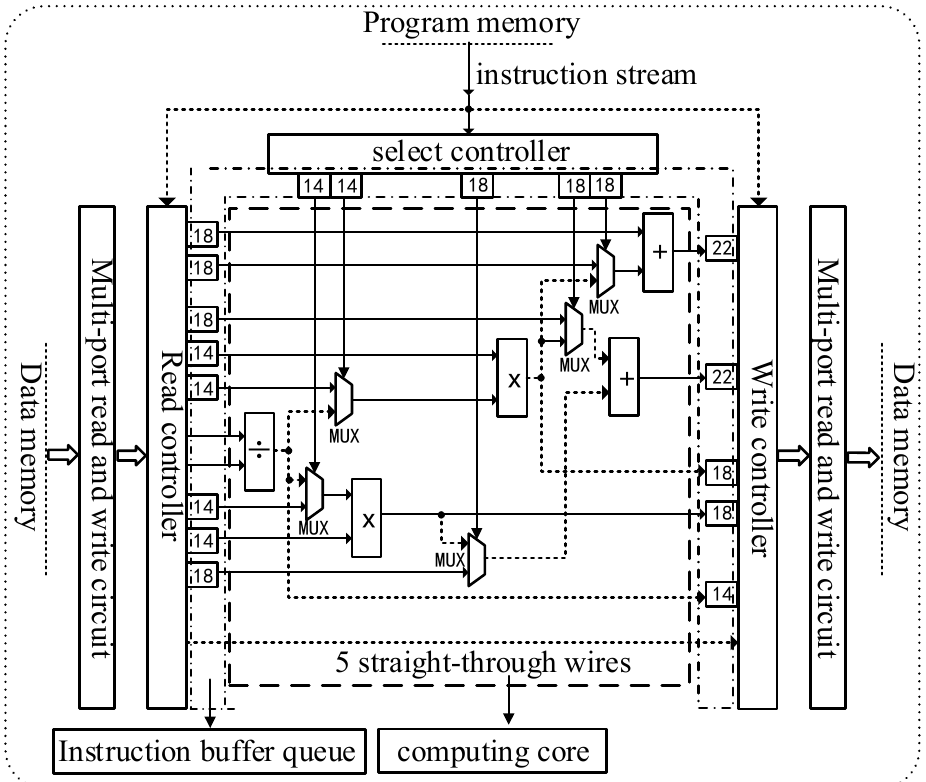
Figure 2. Structure of universal arithmetic components. During the simulation calculations, the switching element is modeled as a binary resistance, and the nonlinear elements are calculated in a piecewise linear manner. The existence of a switching element and a nonlinear element leads to many simulation param- eters having various values. To facilitate the selection of the current value of a multivalued parameter, all the values of a multivalued parameter are stored as an array, in which each element represents the value of a multivalued parameter for a certain case. The information describing the multivalued parameters is stored in the boot word, which includes the starting address of the multivalued parameter array, the address of the affect word, and the decoding method. After obtaining the state of the affect word, FRTDS calculates the address offset according to a certain decoding method and adds this offset to the starting address to obtain the real address of the current value of the multivalued parameter. The specific process is shown in Figure 3. The affect word is divided into internal and external affect words. The state of the internal affect word is determined by the calculation result of the arithmetic component, and the state of the external influence word is determined by the input of the external device.